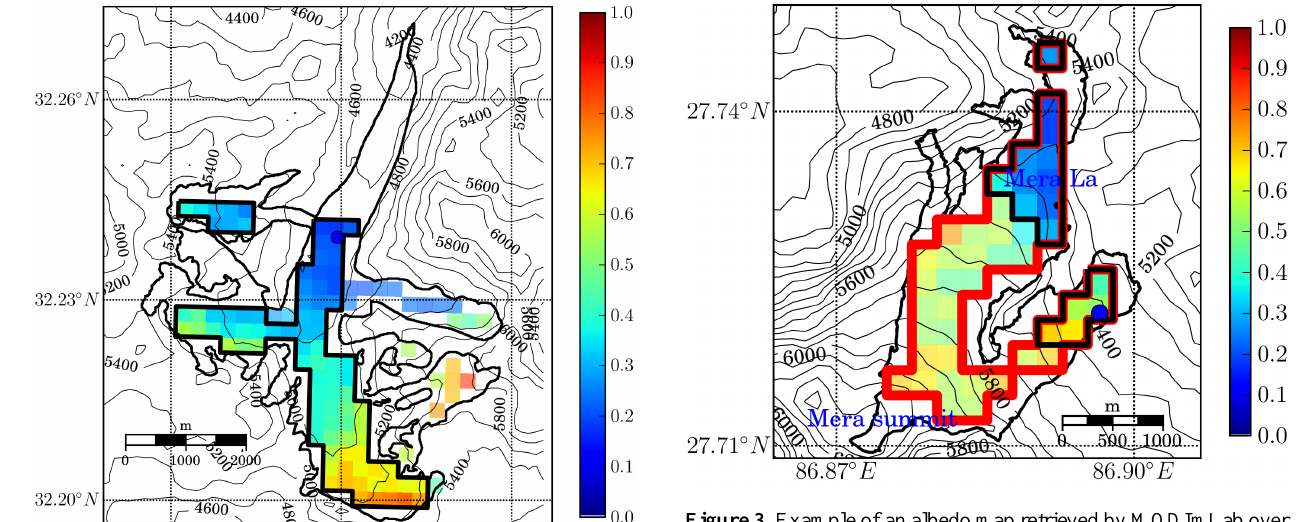
Figure 3. Example of an albedo map retrieved by MODImLab over Mera Glacier on 11 August 2006 04:15:00 (UTC). The bold red line delimits the mask 1 ( n = 44 pixels, corresponding to 2.75km 2 ). The bold black line delimits the mask 2 ( n = 16 pixels, corresponding to 1km 2 ) with pixels located below 5550ma.s.l. The blue dot shows the location of the